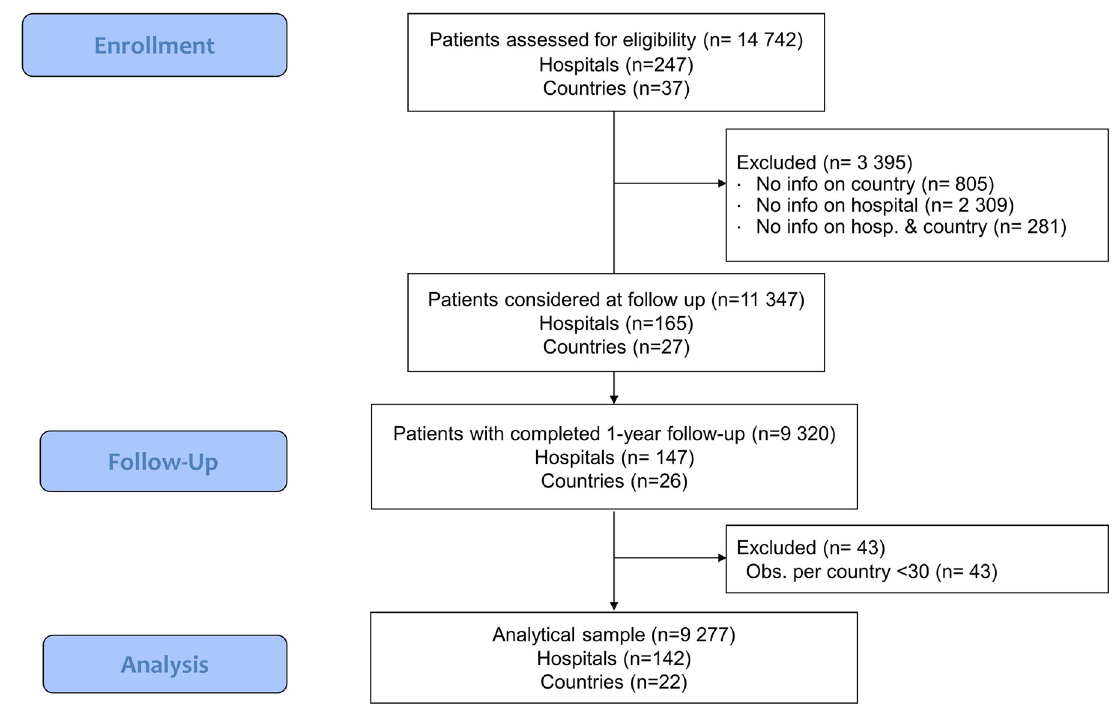
Fig 1. STROBE flow